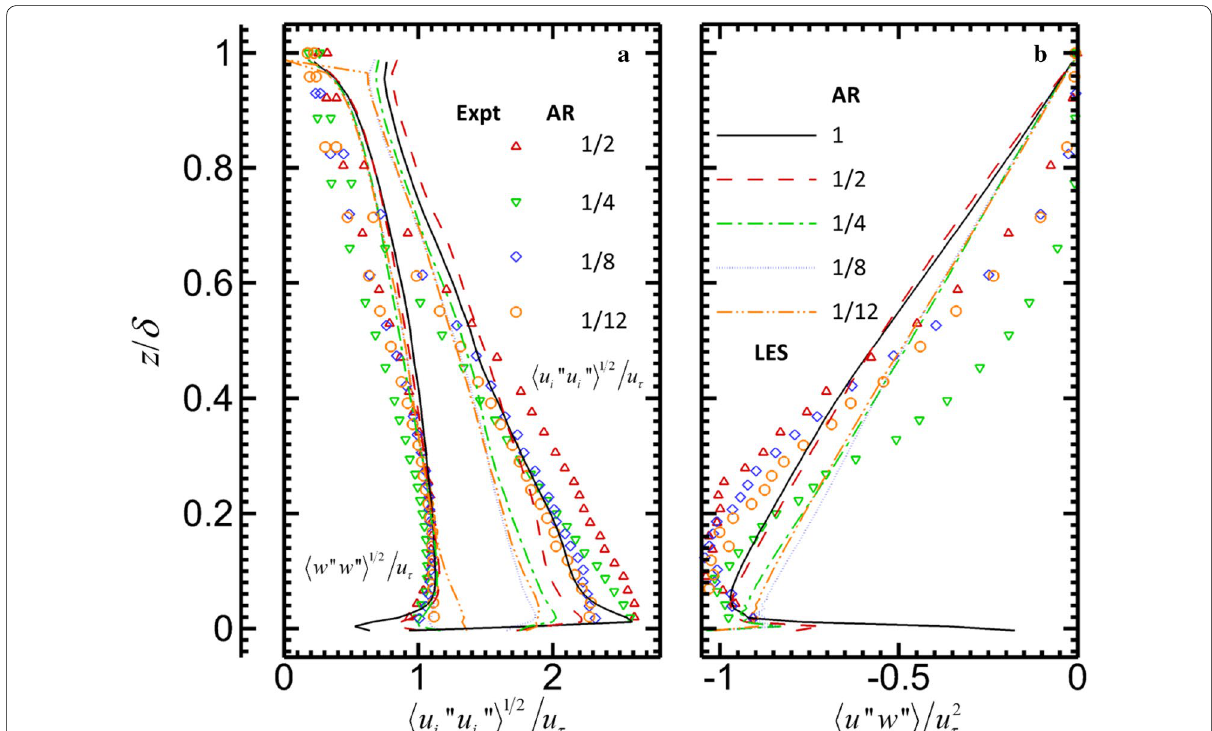
Fig. 4 Dimensionless profiles of: a fluctuating velocities plotted as functions of wall‑normal distance